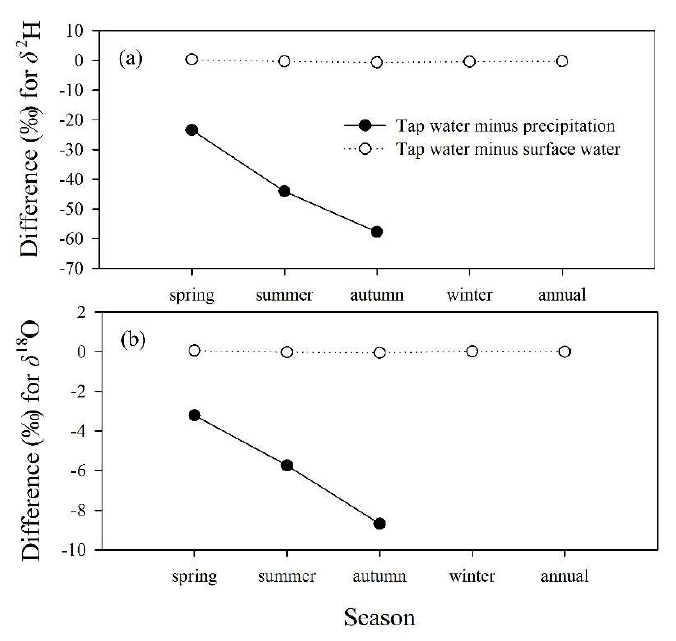
Figure 10. Differences between δ 2 H ( a ) and δ 18 O ( b ) in tap water and those in collected precipitation and surface water.